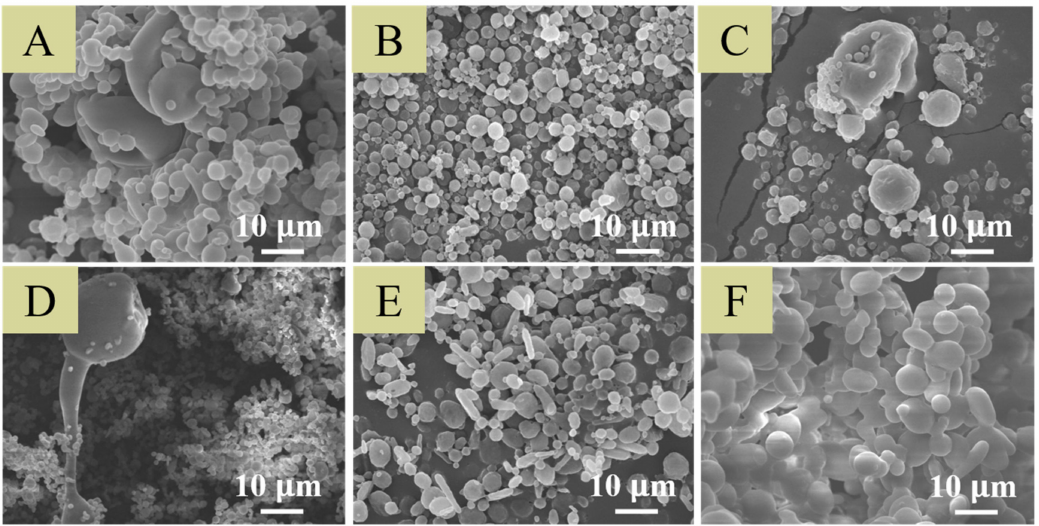
Figure 2. Field emission scanning electron microscopy images of analgesics-loaded microparticles subjected to various processing conditions after being gold-sputtered. Conditions were: ( A ) 9 kV, 1 mL / h, and 5 cm; ( B ) 9 kV, 1 mL / h, and 10 cm; ( C ) 9 kV, 1 mL / h, and 20 cm; ( D ) 6 kV, 1 mL / h, and 10 cm; ( E ) 15 kV, 1 mL / h, and 10 cm; and ( F ) 9 kV, 2 mL / h, and 10 cm for voltage, flow rate, and travel distance, respectively. Scale bar = 10 µ m.